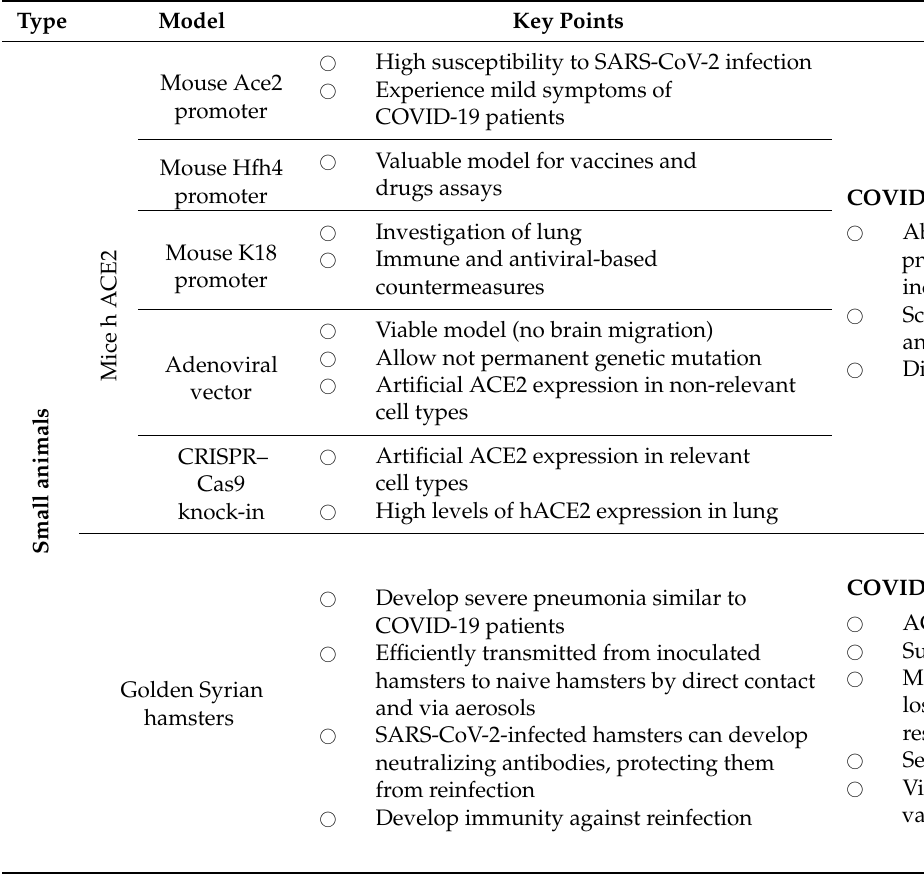
Table 2. Animal models: key points, benefits, and limitations in COVID-19